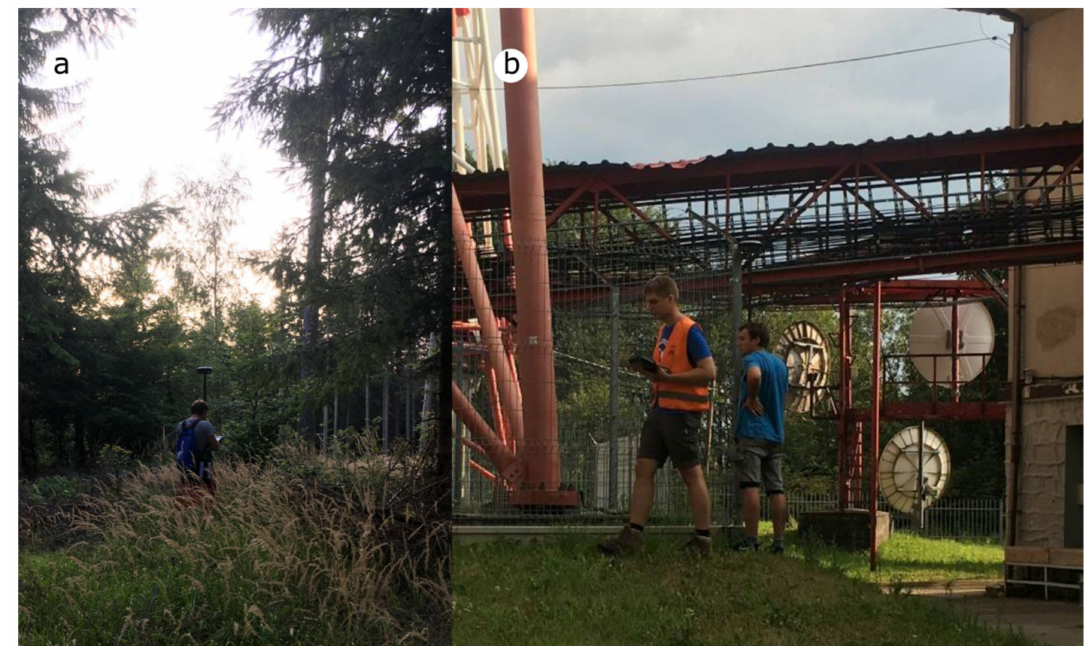
Figure 10. Images showing examples of measurement obstacles at the mountain peaks. ( a ) Mount Folwarczna and ( b ) Mount Chełmiec. Author: Krystian